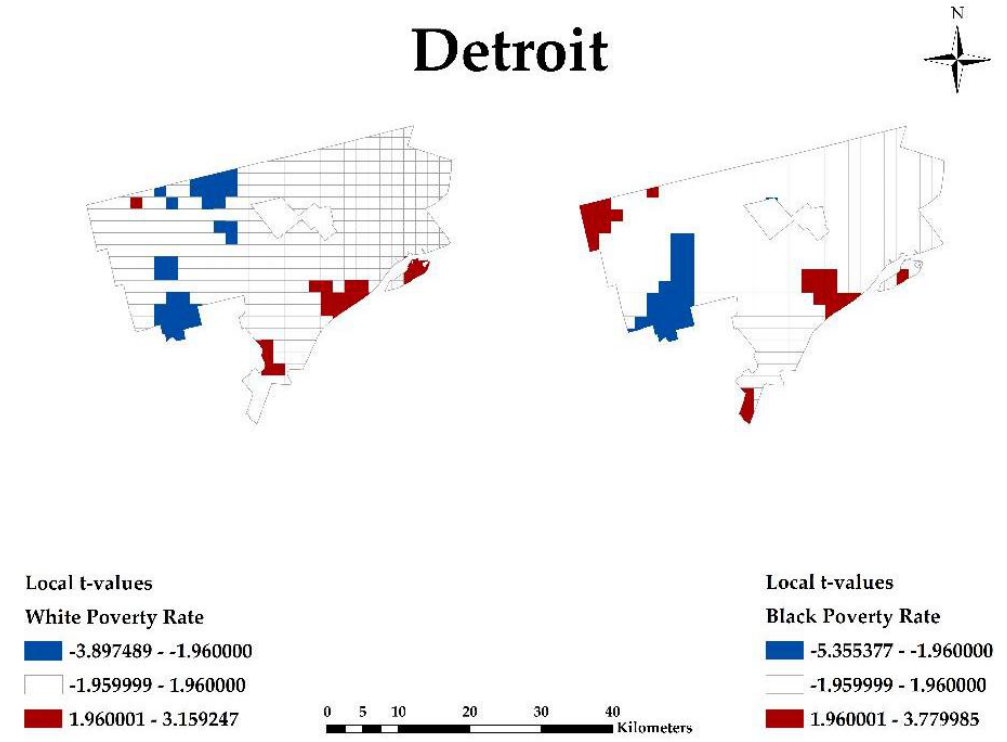
Figure 8. Chicago shrinking city Percent White and Percent Black: 95% two-tailed test ( − 1.96:1.96).